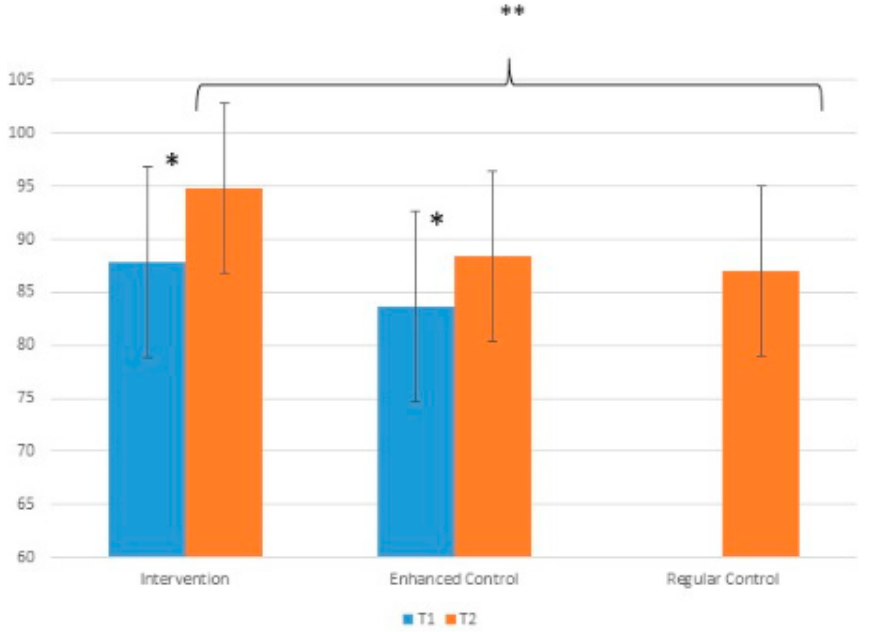
Figure 2. PPE over time across study groups. * denominates significant difference ( p < 0.05) between T1 and T2. ** denominates significant difference ( p < 0.05) between intervention and regular control at T2. Error bars show standard deviation